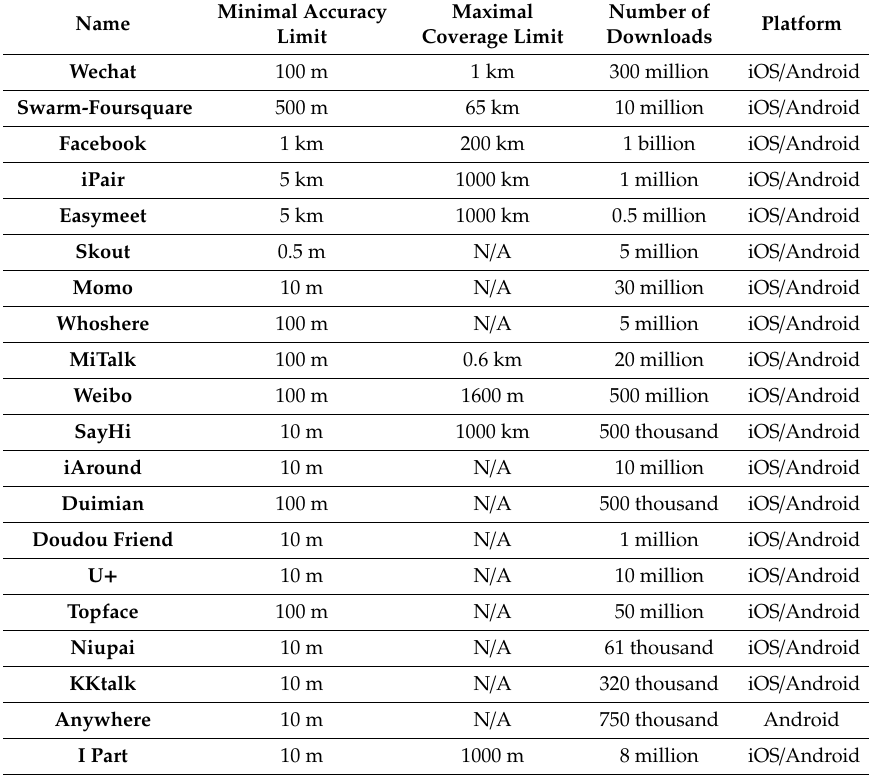
Table 2. List of the existing geosocial